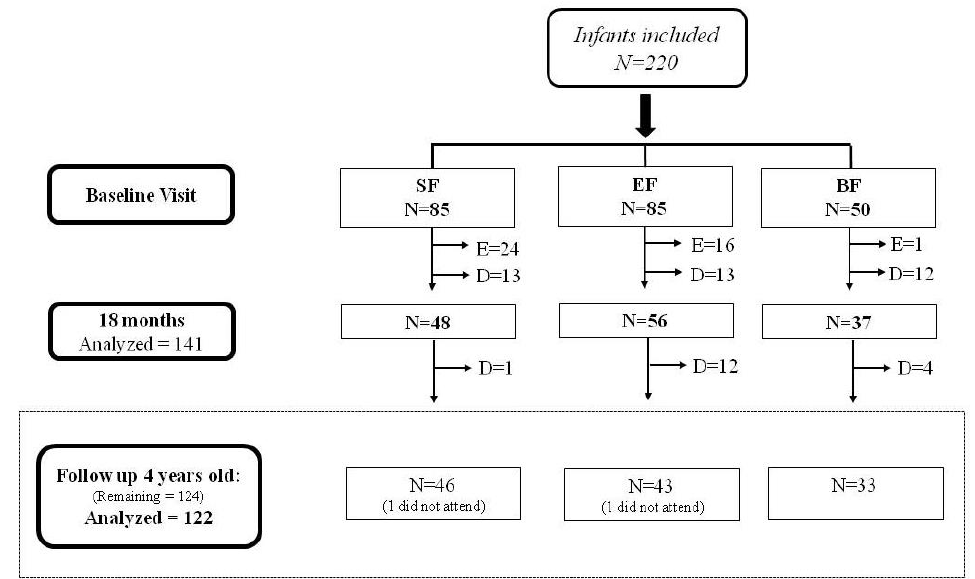
Figure 1. Participant flowchart from baseline visit to four years old. SF: Standard infant formula; EF: Experimental infant formula; BF: Breastfed infants; D = Dropouts; E = Exclusions. Up to 18 months of life, a total of 40 infants were excluded in the SF and EF groups as follows: 24 were excluded in the SF group (1 infant due to perinatal hypoxia, 1 infant had growth deficiency, 15 infants did not take the infant formula, 2 had colic of the infant, 3 were excluded due to lactose intolerance, 1 infant due to digestive surgical intervention, and 1 infant suffered hydrocephalus); 16 infants were excluded in the EF group (2 infants presented growth deficiency, 2 infants lactose intolerance, 11 infants did not take the infant formula, and 1 was excluded due to epileptic seizure). Furthermore, one infant of the BF group was excluded because he/she was not breastfed. During the follow-up visit at four years old, dropouts were considered those who did not continue to participate in the study; n = sample size.